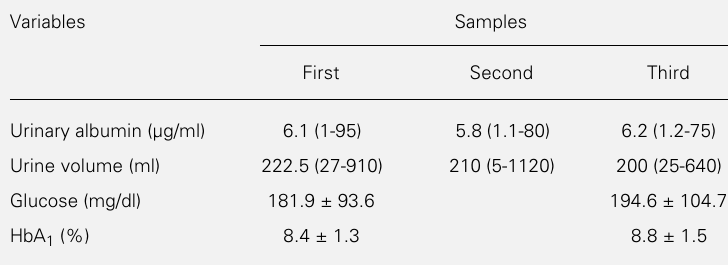
Table 1 - First morning urine albumin concentration, volume, fasting blood glucose and HbA 1 of 50 IDDM